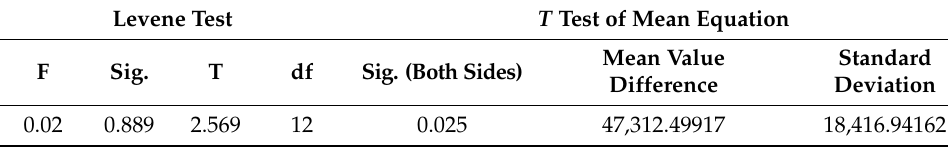
Table 2. Mann ‒ Whitney-U-test results for the number of erosion-crater pores on the surfaces. Table 3. Results of t tests of the eggshells’ calcium contents. Levene Test T Test of Mean